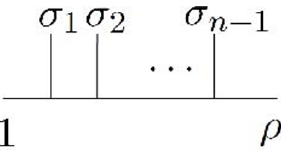
Figure 13 . Half-ladder diagrams that characterize the numerators in DDM basis where 1 and the off-shell line n (with the Lorentz index ρ ) are considered as the leftmost and the rightmost elements.